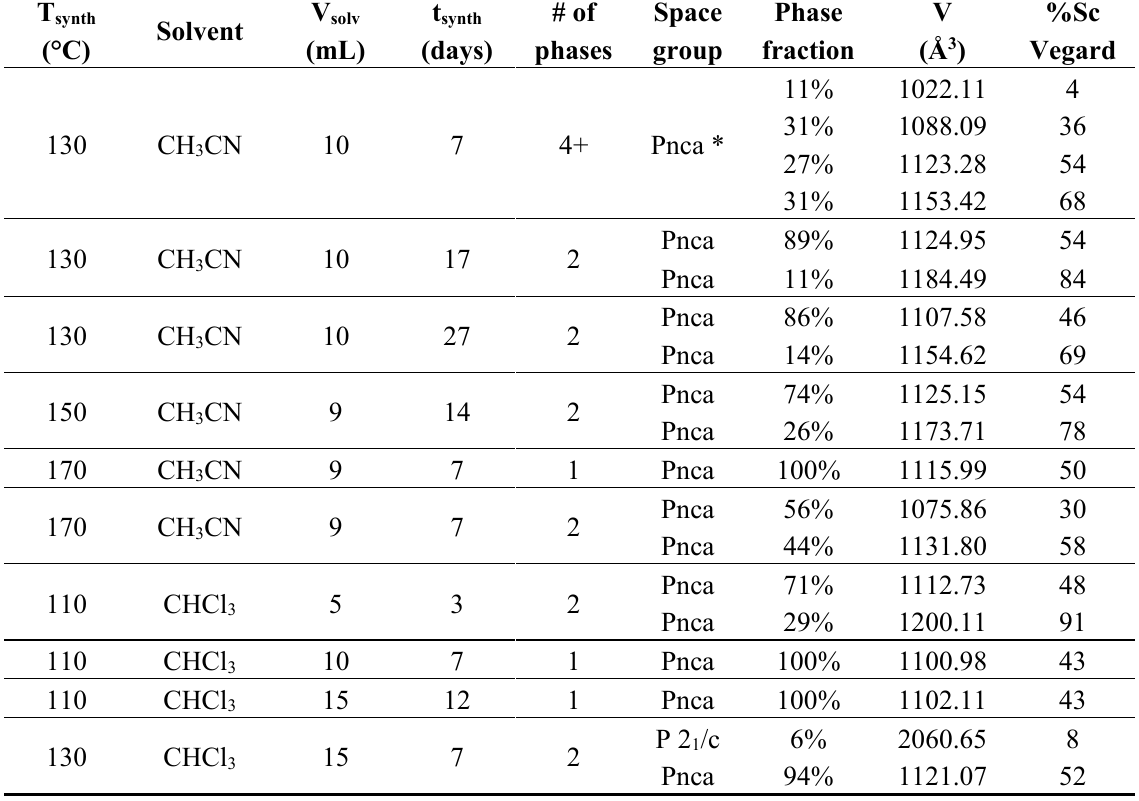
Table 1. Reaction conditions and refinement results for selected AlScMo 3 O 12